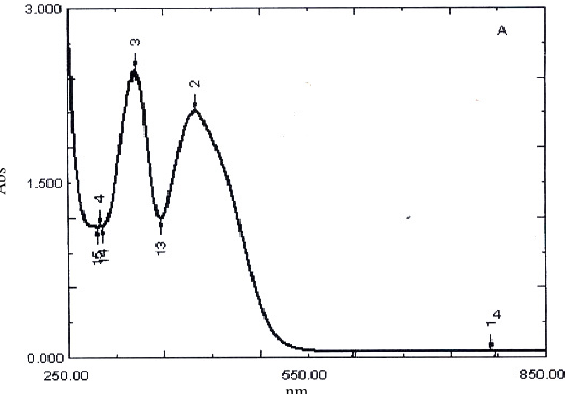
Figure 1. Spectrum of sulphanilic azo imidazole dye A